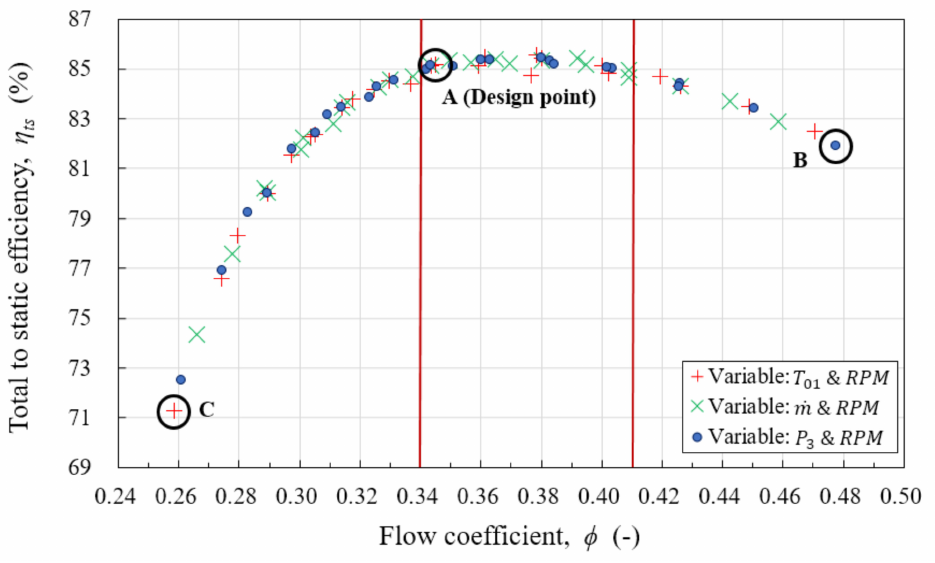
Figure 13. Total-to-static e ffi ciency according to the flow coe ffi cient ( φ )